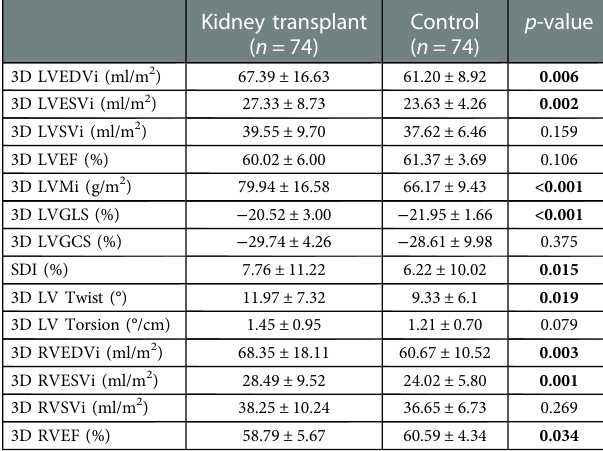
TABLE 3 Comparison of 3D and speckle-tracking echocardiographic data in the kidney transplant and the control